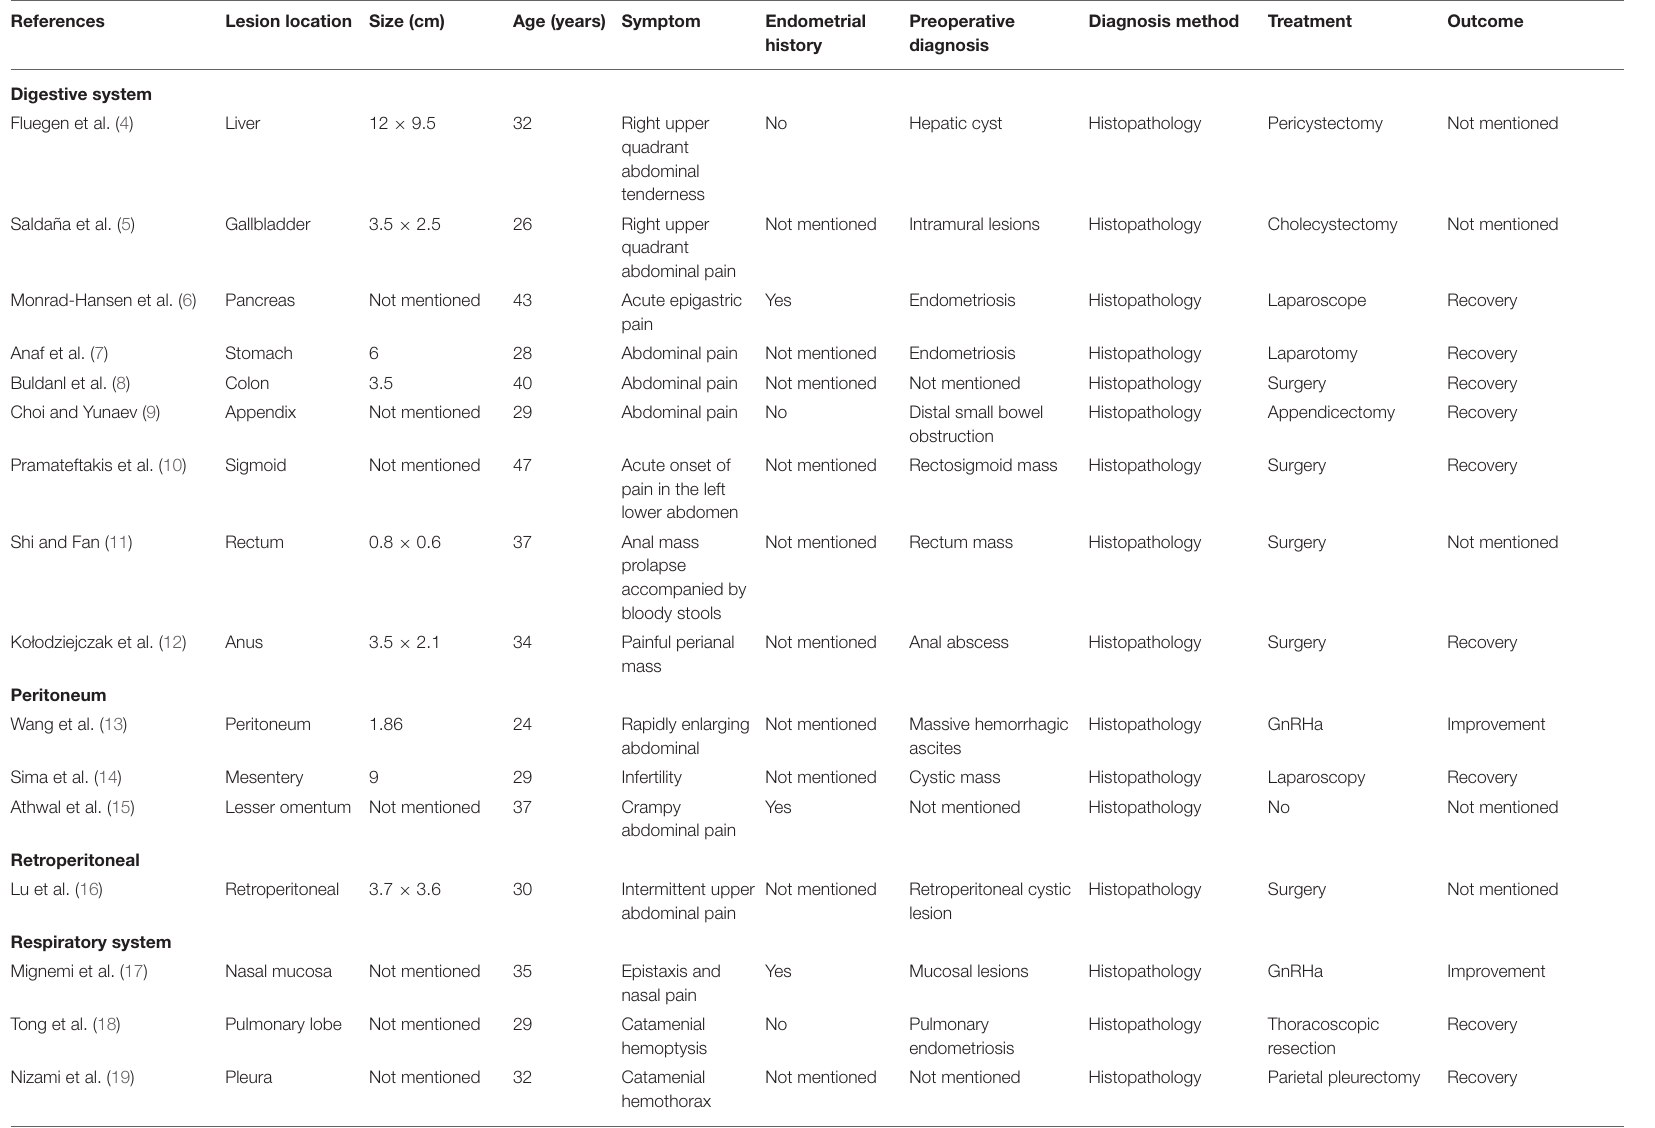
TABLE 1 | Extragenital